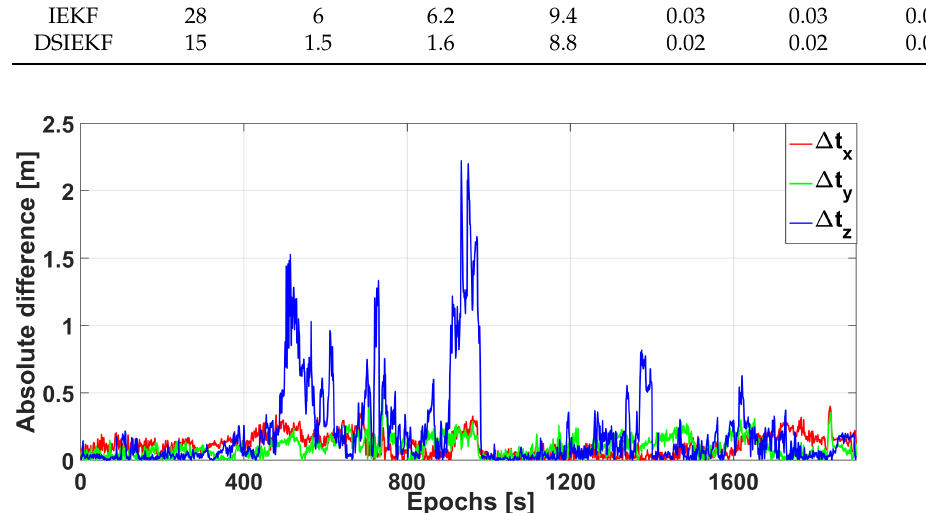
Figure 11. Absolute differences between the estimated translation parameters by means of IEKF and DSIEKF.